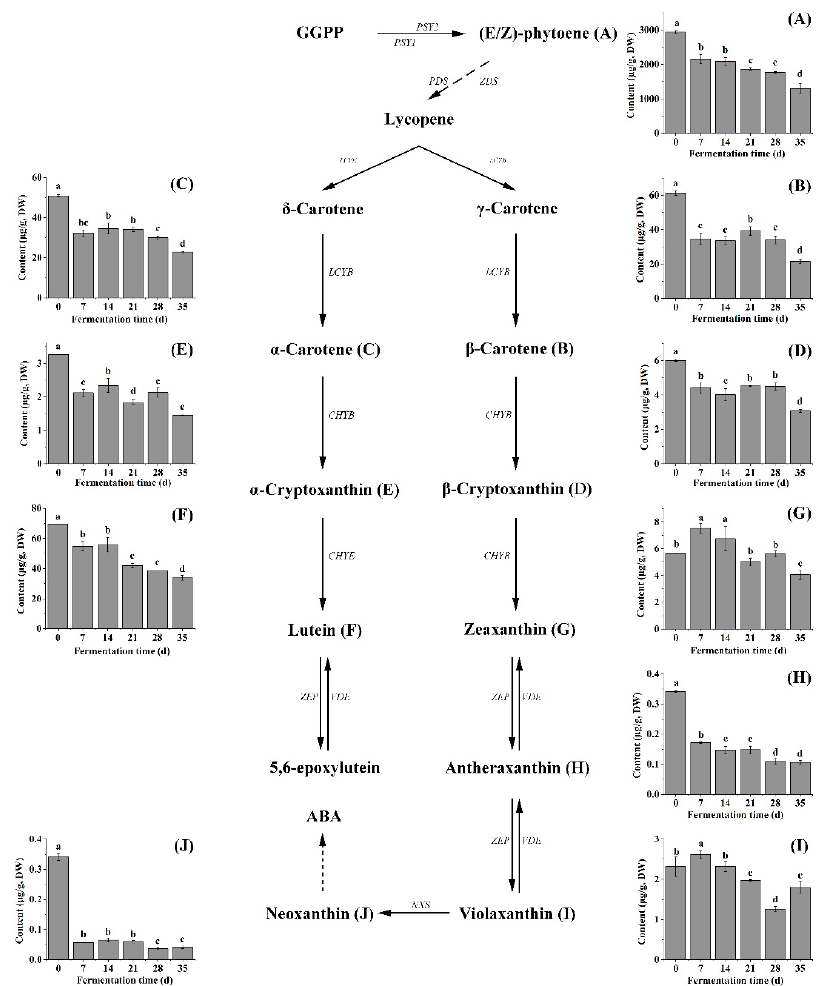
Figure 1. Changes in the content of carotenoids during fermentation. ( A ) (E/Z) ‐ Phytoene. ( B ) β‐ Carotene. ( C ) α‐ Carotene. ( D ) β‐ Cryptoxanthin. ( E ) α‐ Cryptoxanthin. ( F ) Lutein. ( G ) Zeaxanthin. ( H ) Antheraxanthin. ( I ) Violaxanthin. ( J ) Neoxanthin. The different letters in the same figure indicate significantly different ( p < 0.05).